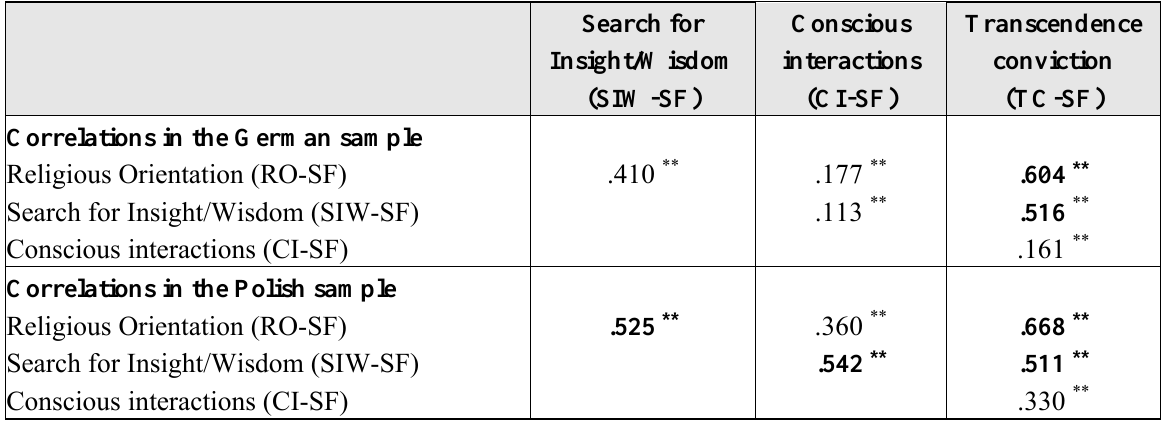
Table 8. Correlations between the Aspects of Spirituality (ASP)-Student scales in the German and Polish